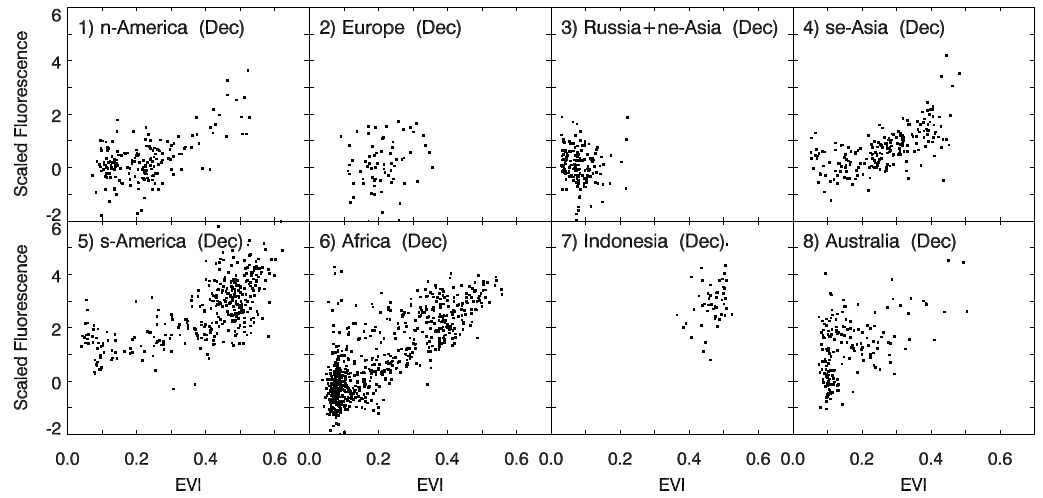
Fig. 15. Similar to Fig. 14 but showing scaled F from the P polarization versus the MODIS enhanced vegetation index (EVI) (both unitless) for December 2009.